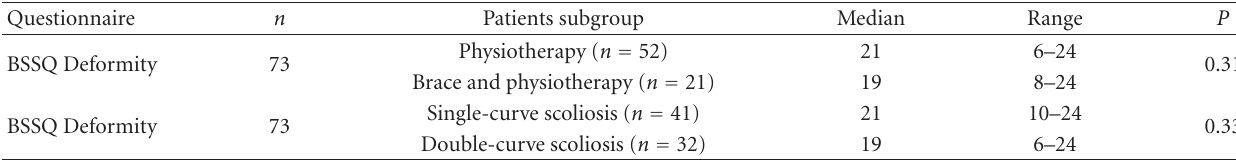
Table 2: Medians of the BSSQ-Deformity in two subgroups of patients depending on the method of treatment and the number of curvatures of scoliosis.